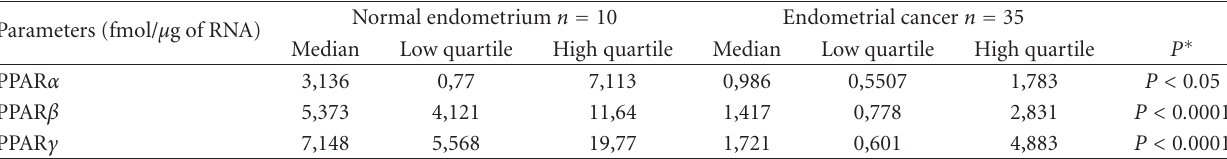
Table 1: Expression of PPARs mRNA in normal and endometrial cancer tissues ( ∗ Mann-Withney test). Parameters (fmol/ μ g of RNA)